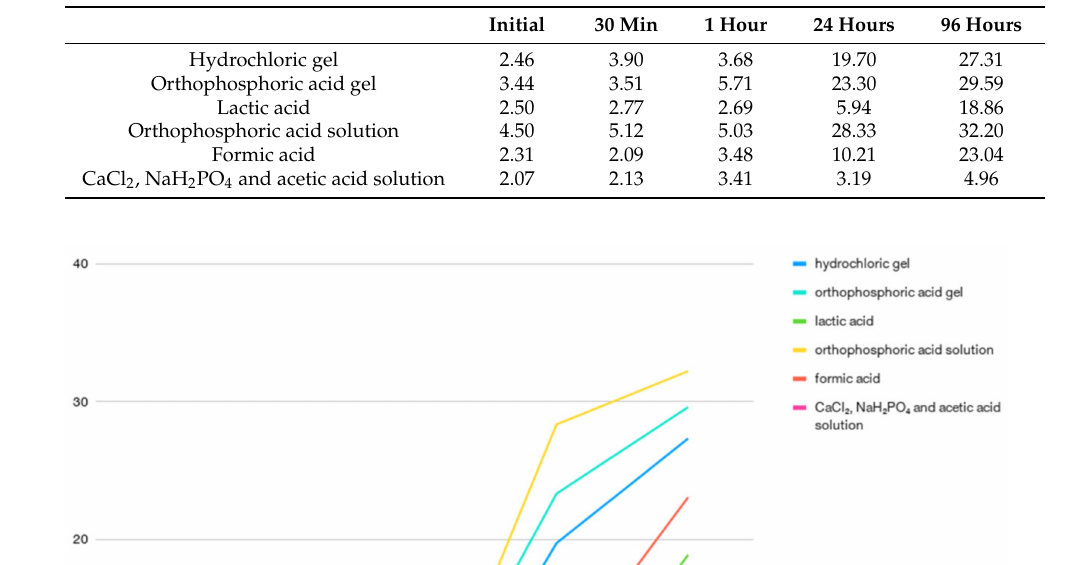
Table 3. The mean results from the DIAGNODent™ pen before and after the application of acid solutions on the enamel surface.